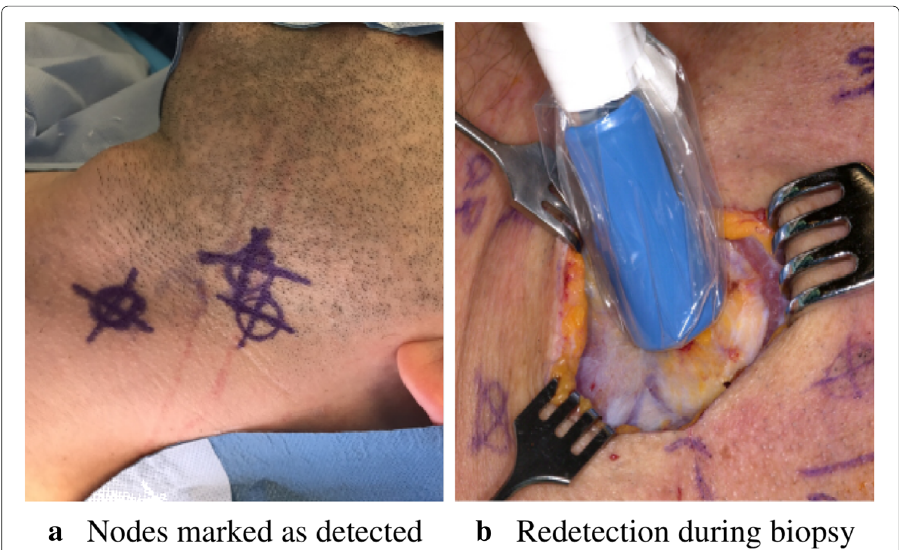
Fig. 1 Two consecutive intervention steps of the current SNB procedure: a prior to the intervention, lymph nodes are localized and hand-marked accordingly. b As tissue is pushed away during the biopsy, the lymph nodes need to be redetected using the gamma